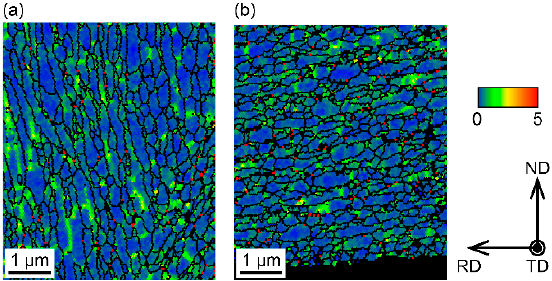
Figure 3. Kernel average misorientation (KAM) maps of chip specimen ( a ) at center in the thickness direction and ( b ) near rake face.